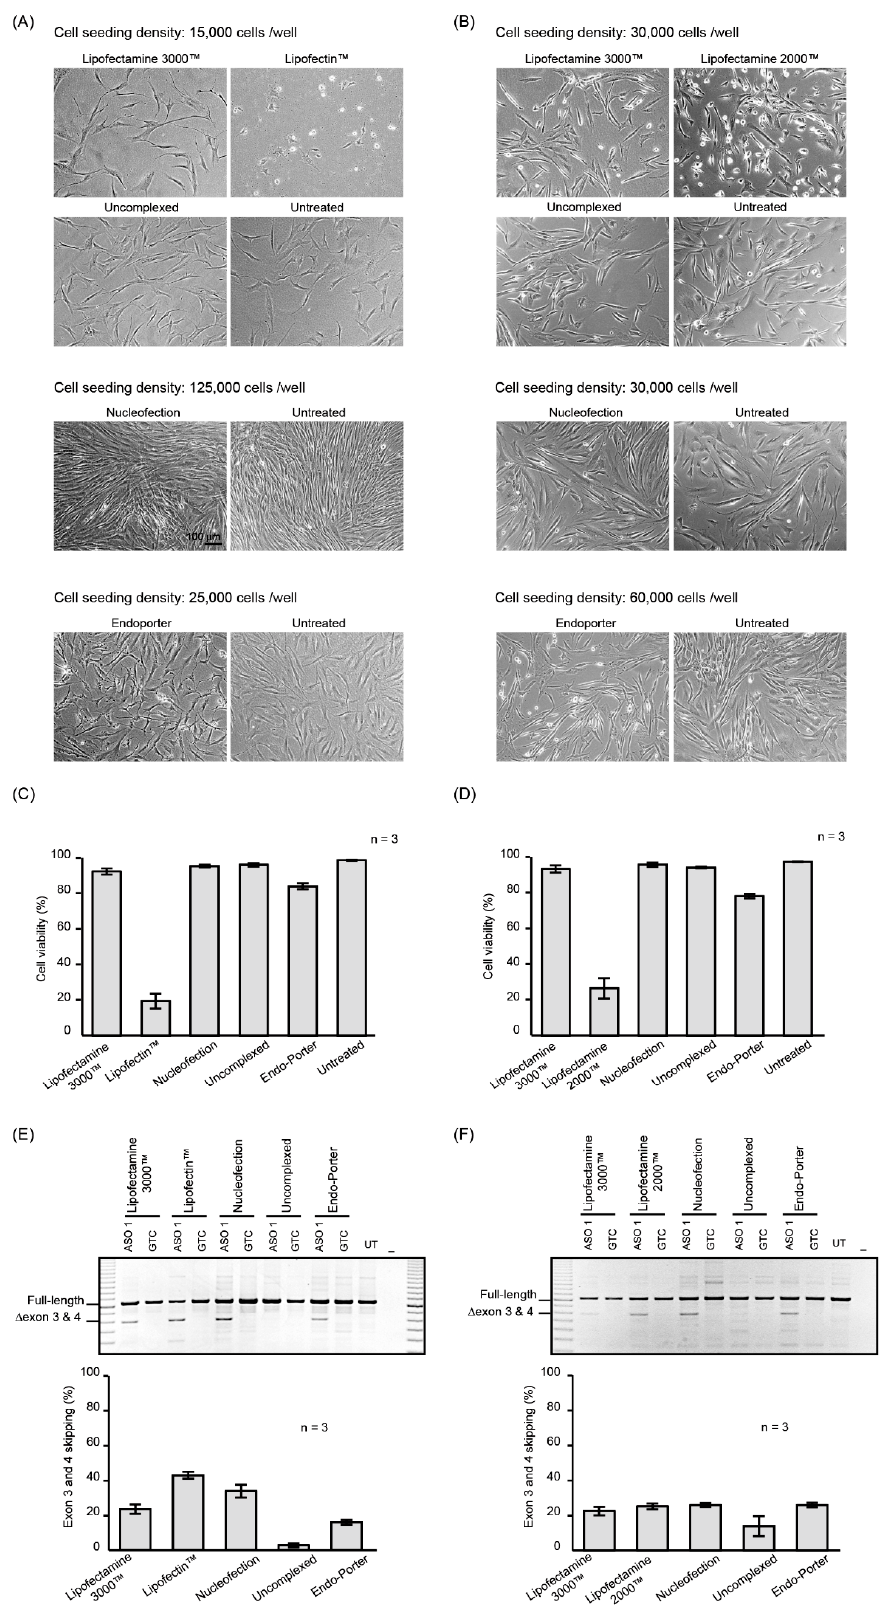
Figure 1. Micrographs of fibroblasts ( A ) and myoblasts ( B ) treated with 10 µ M of ASO 1 for 24 h using the delivery methods indicated above each panel. Cell viability of ( C ) fibroblasts and ( D )